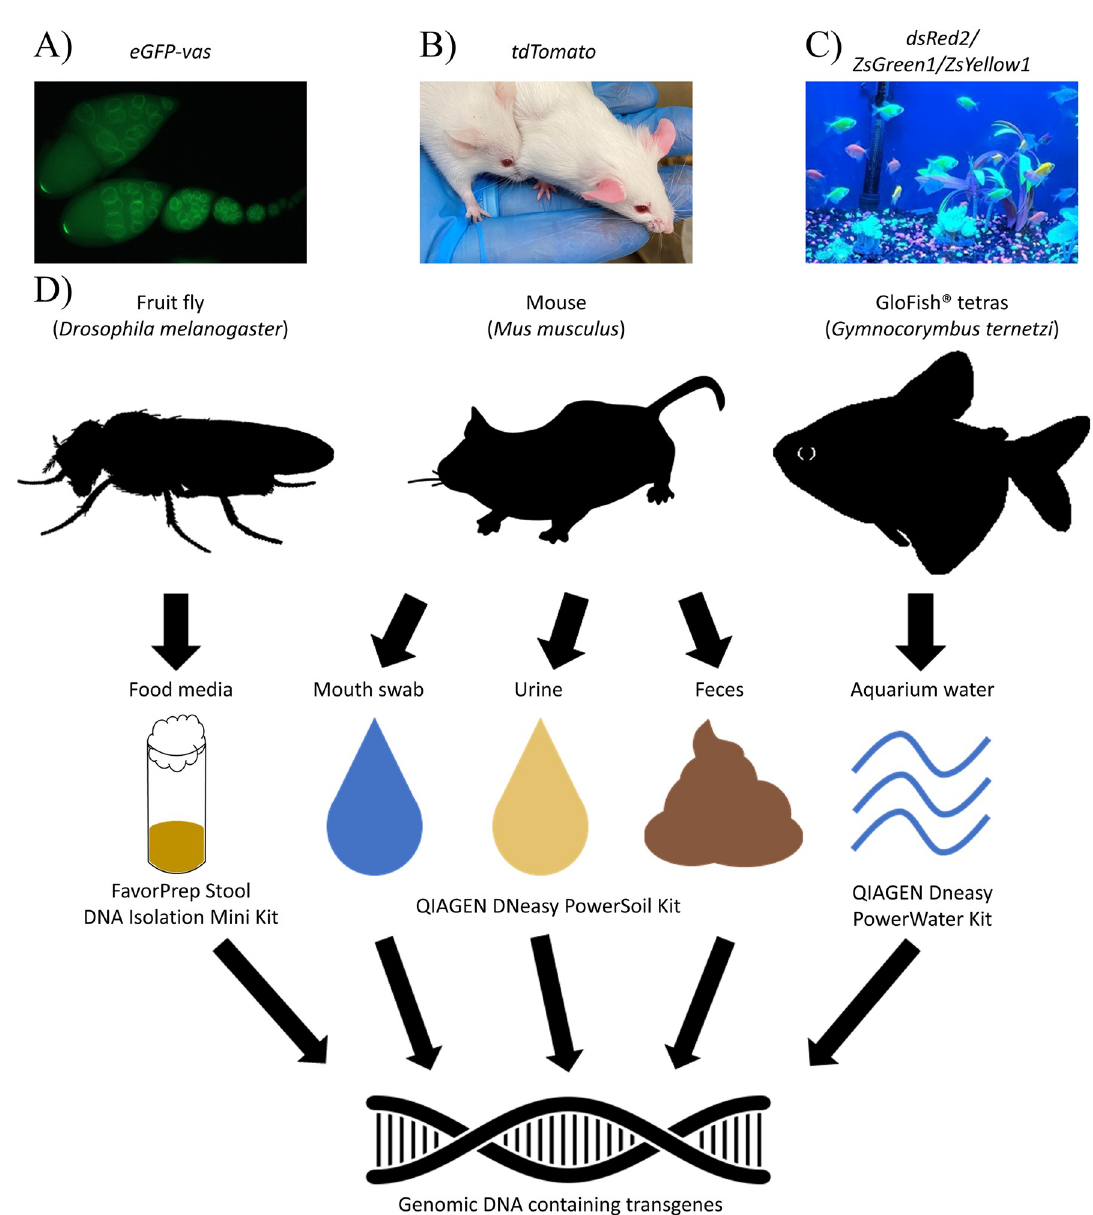
Fig 1. A) Green fluorescent ovary tissue of genetically modified fruit fly ( Drosophila melanogaster ) expressing green fluorescent protein tagged vasa gene ( eGFP-vas ). B) Laboratory mice ( Mus musculus ) genetically modified to express tdTomato transgene exhibiting reddish skin (right) compared to without tdTomato (left). C) Multicolored fluorescent GloFish 1 tetras ( Gymnocorymbus ternetzi ) expressing combinations of transgenic fluorescence genes in a commercial pet store aquarium. D) Non-invasive environmental DNA samples from a diversity of sources (food media, saliva, urine, feces, and aquarium water) were collected and processed using standard commercial DNA extraction kits. For the mammalian system, we used a laboratory mouse strain carrying the tdTomato trans- gene (JAX stock number: 007905, Strain Name: B6;129S6- Gt(ROSA)26Sor tm9(CAG-tdTomato)Hze /J) obtained from the McGill Integrated Core for Animal Modeling. We extracted non-invasive extra-organismal DNA from feces inside the housing cage, from ~0.2 mL of urine, and from a cotton oral swab (~ 30 seconds) collected from a single individual. While these samples are